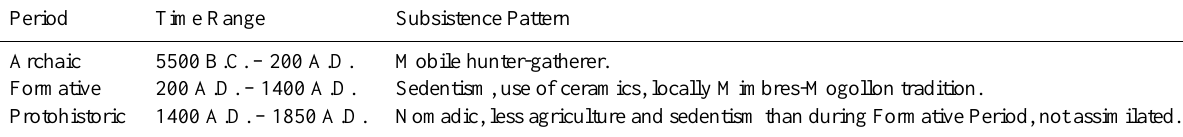
Table 1. Period designations, including duration and subsistence patterns for the American